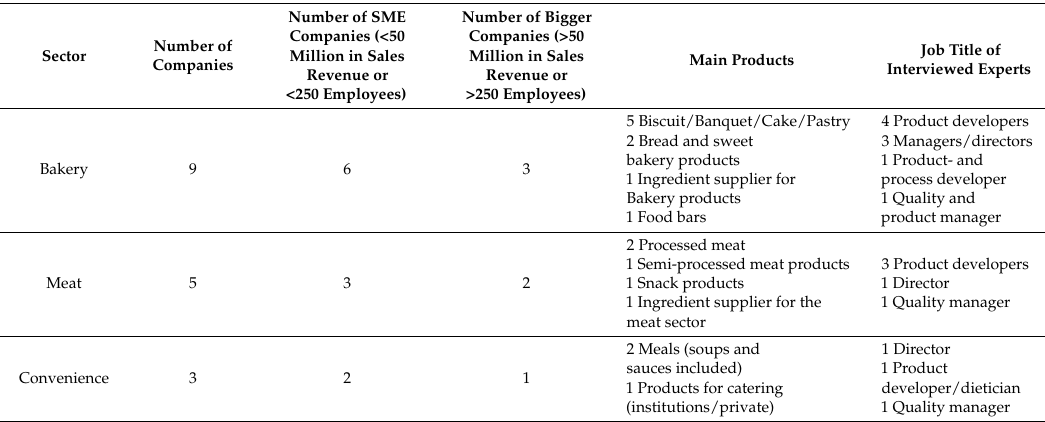
Table 1. Study group food companies ( n = 17): sectors, number and size companies, main products and employment of interviewed